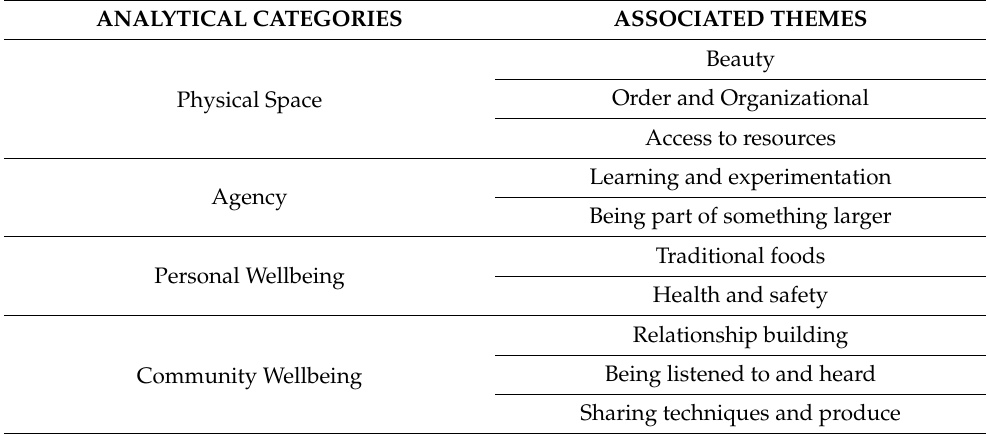
Table 3. Analytical categories and associated themes from the emergent thematic analysis. The themes are interpretive groupings of related codes identified during the analysis; categories reflect shared attributes of related